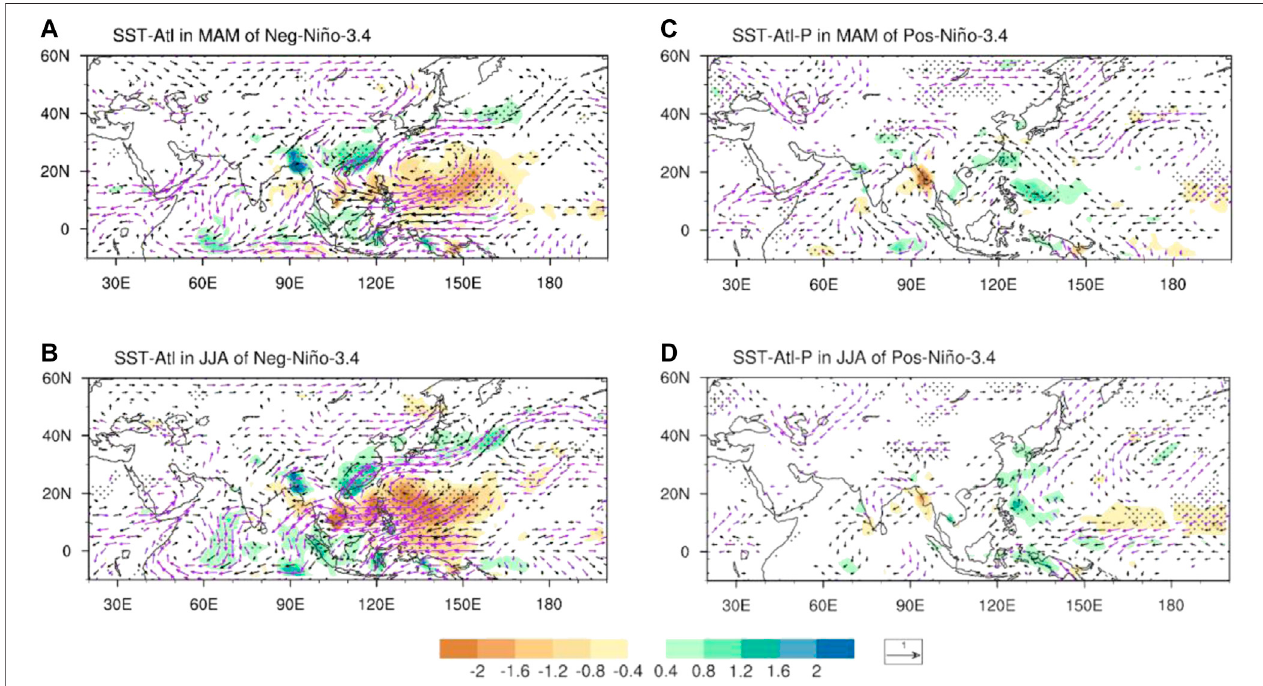
FIGURE8 | Regression ofsummerprecipitation (shading, mm day − 1 ) and integrated 1,000 – 300 hPawatervapor fl uxes (vectors,kg m − 1 s − 1 ) in JJA onto (A,B) the SST-Atl index in negative Niño-3.4summers and (C,D) the SST-Atl-P index in positive Niño-3.4 summers. (A,C) spring and (B,D) summer. Stippling and purple vectors are signi fi cant at the 90% con fi dence level.